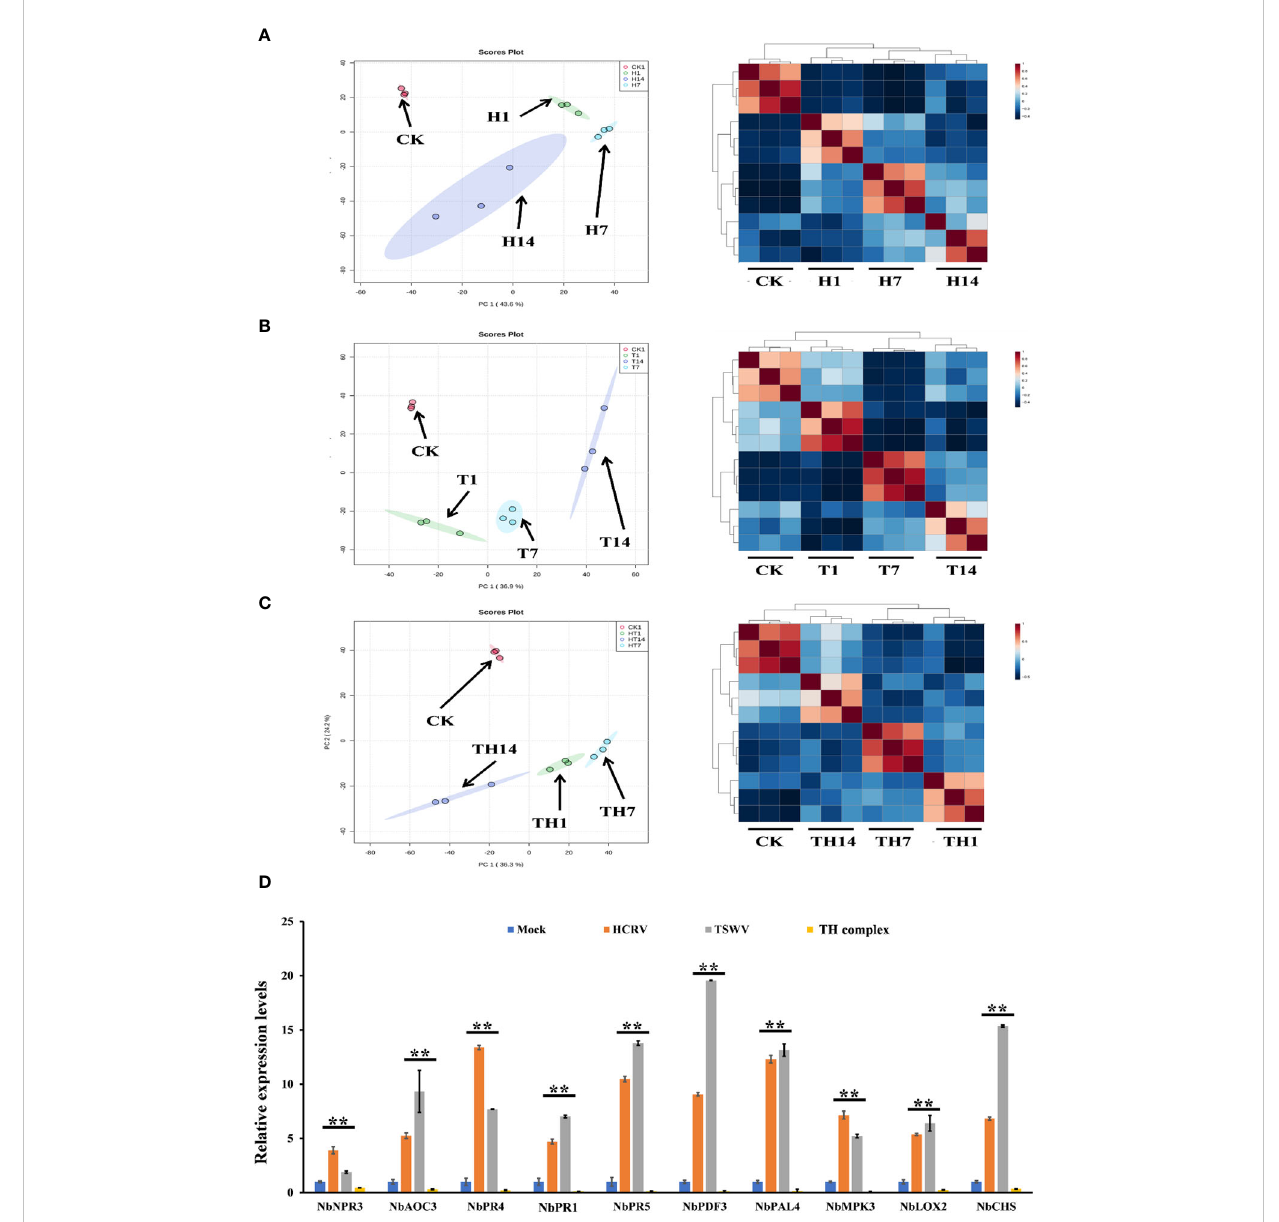
FIGURE 2 H, T, and TH inoculation caused dramatic variations in the transcriptome of Nicotiana benthamiana . Principal component analysis on the transcriptome pro fi les of tobacco ( N. benthamiana ) at 1-, 7-, and 14-days post-inoculation of H (A) , T (B) , and TH (C) . All the samples are shown in different colors and clustered into one region according to their treatments. The T ellipse represents the 95% con fi dence interval. Principal components 1 and 2 were used to construct the PCA plots. Unsupervised hierarchical clustering displays the correlation between the samples